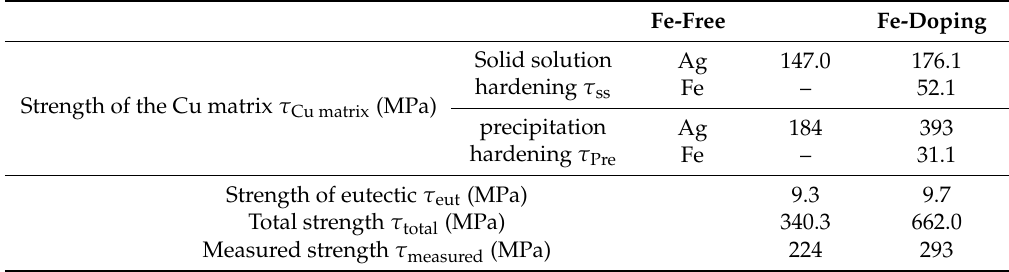
Table 3. Individual contributions to the strength of both Fe-free and Fe-doping alloys aged at 550 ◦ C for 4